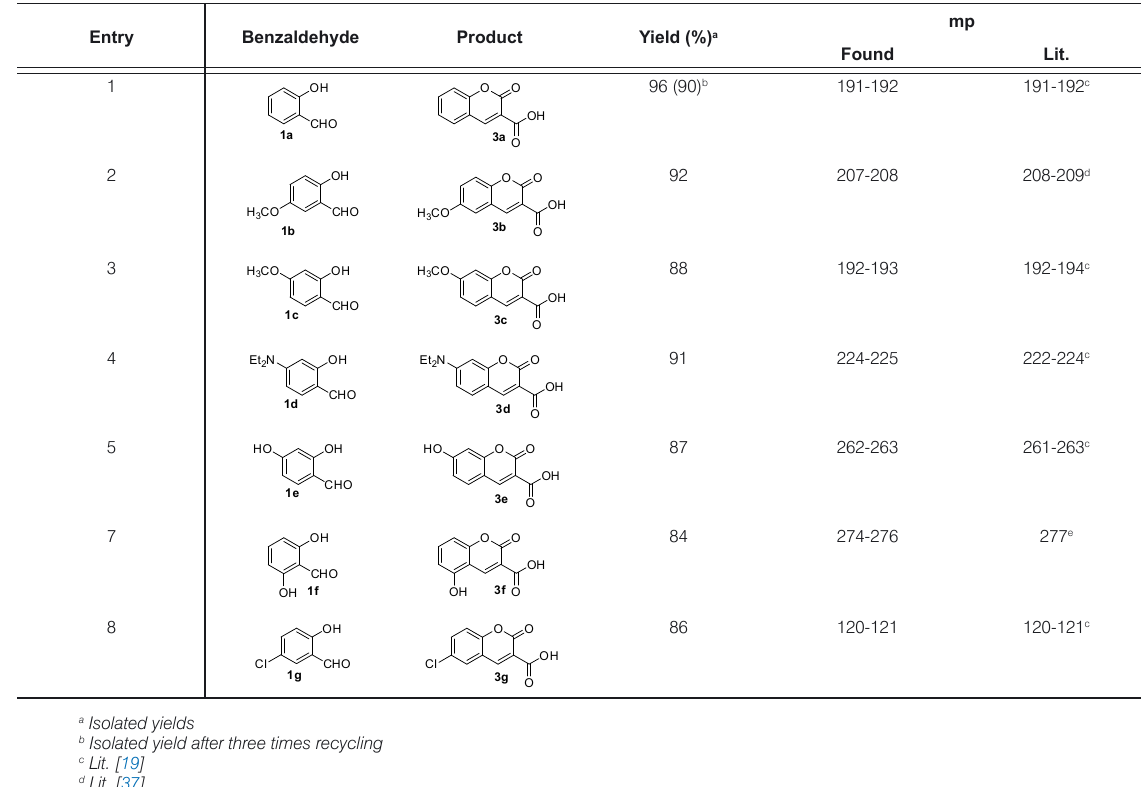
Table 1. Synthesis of